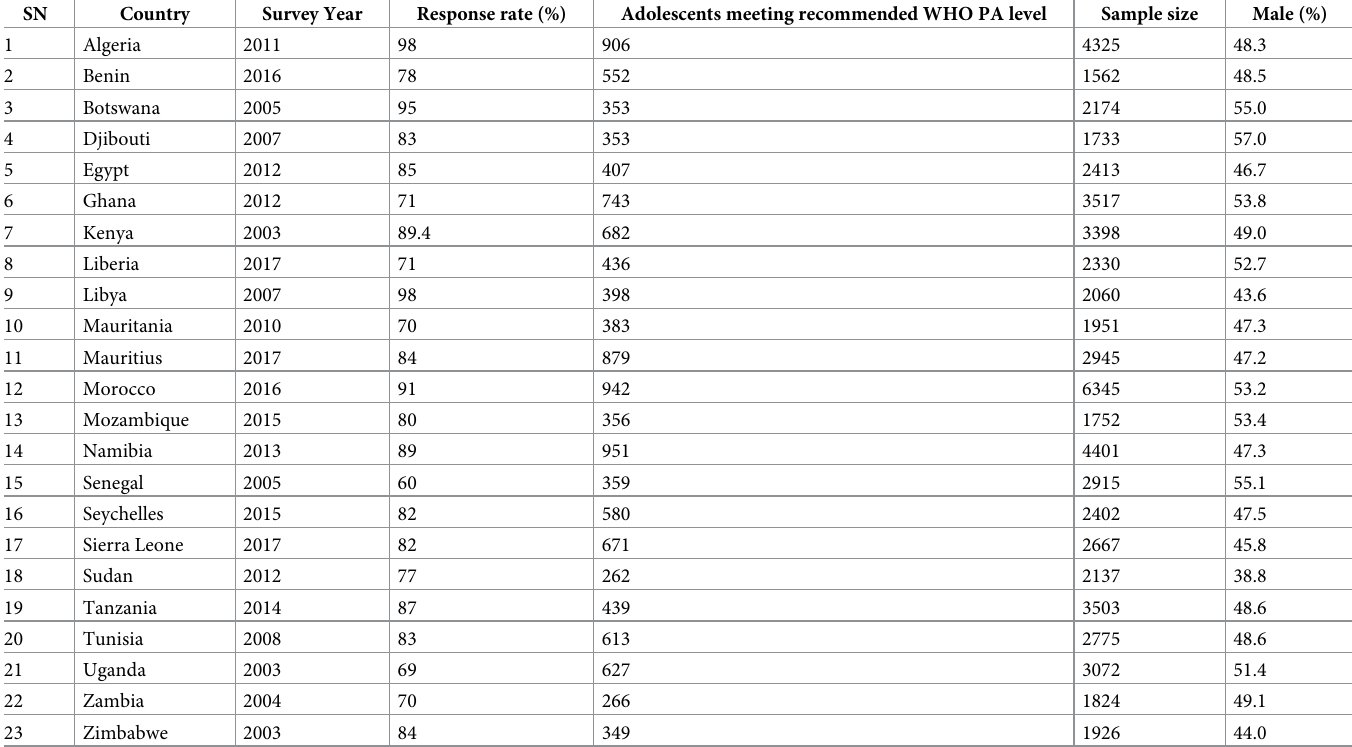
Table 1. Characteristics of the adolescents included in the GSHS from 23 African countries (n =